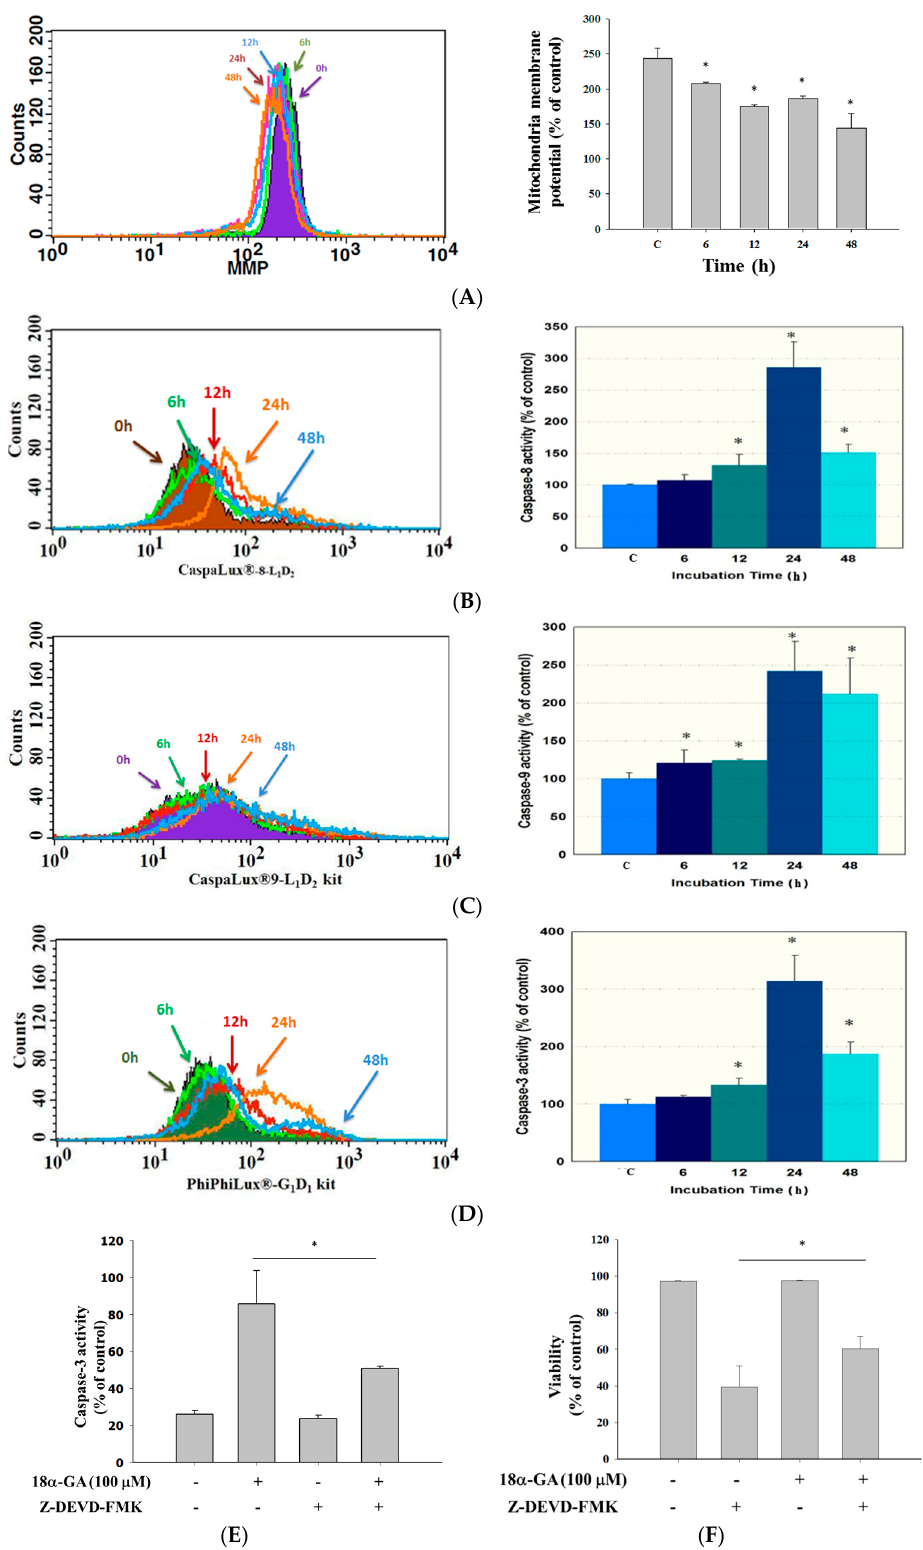
Figure 3. 18 α -GA decreased the levels of mitochondrial membrane potential ( ΔΨ m) and increased the activities of caspase-8, -9 and -3 in HL-60 cells. Cells were treated with 18 α -GA (100 μ M) for 6, 12, 24 and 48 h and were analyzed by flow cytometric assay for the levels of mitochondrial membrane potential ( ΔΨ m) ( A ); caspase-8 ( B ); caspase-9 ( C ) and caspase-3 ( D ) activities. Cells were pretreated with z-DEVD-FMK (caspase-3 inhibitor) and then treated with 18 α -GA for measuring the activities of caspase-3 ( E ) and cell viability ( F ). * p < 0.05, significant difference between 18 α -GA-treated groups and the control as analyzed by Student’s t test.